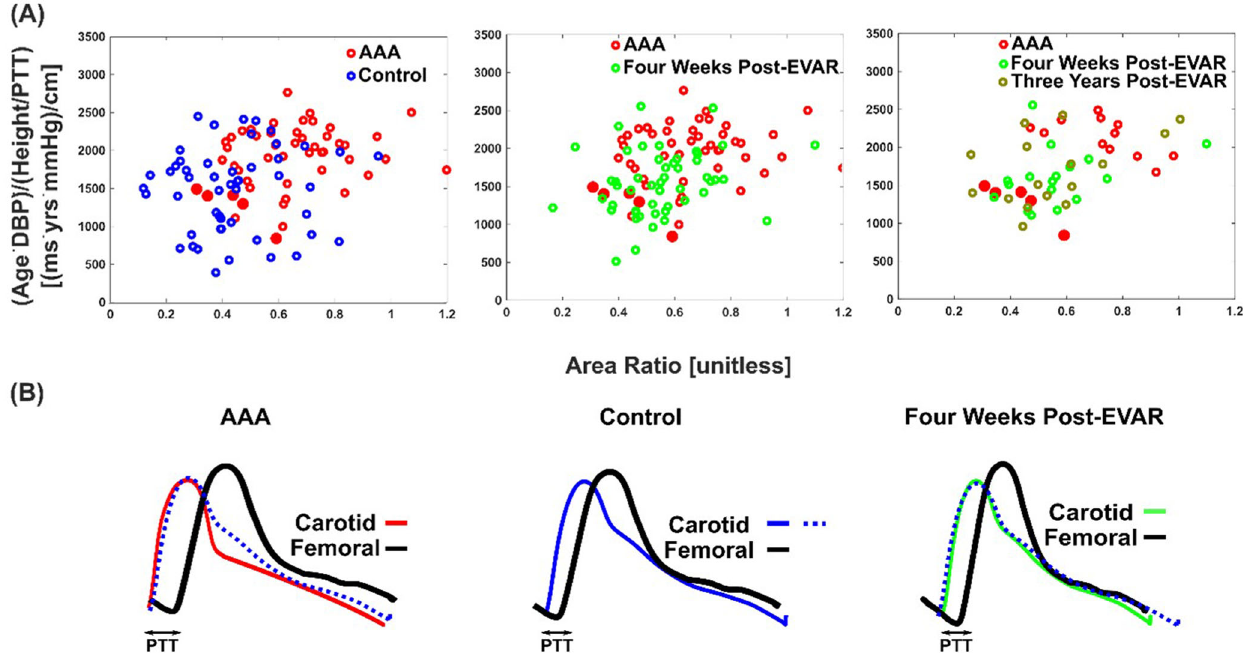
Fig. 8 Individual patient results and examples. A Plots of normalized PTT versus the area ratio per patient for each of the three classi fi cation tasks (see Figs. 6 and 7). The red fi lled circles are fi ve of the seven AAA datapoints that overlap most with the control and post-EVAR datapoints and thus least discriminating. B Visually apparent examples of the differences in the carotid and femoral artery waveforms from AAA (before and after EVAR) and control patients. The waveforms are ensemble averaged waveform beats of a patient. The solid blue waveform beat in the center panel was redrawn as a dashed blue waveform beat in the left and right panels to facilitate